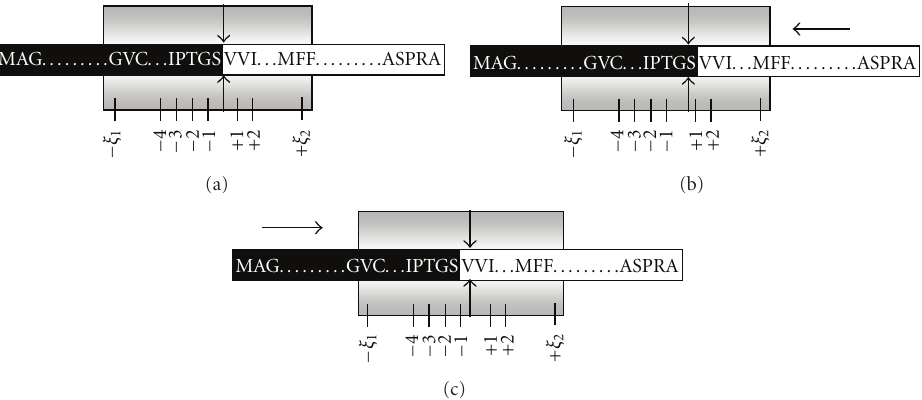
Figure 3: Illustration to show the sequence segments highlighted by sliding the scaled window [ − ξ the sliding process, the scales on the window are aligned with di ff erent amino acids so as to define di ff erent peptide segments. When the scale − 1 is aligned with the tail residue of the signal sequence and scale +1 aligned with the head residue of the mature protein as shown in (a), the peptide segment is seen within the window regarded as secretion cleavable. Peptide segments seen within the window for all the other cases, such as those shown in ((b) and (c)), are regarded as nonsecretion